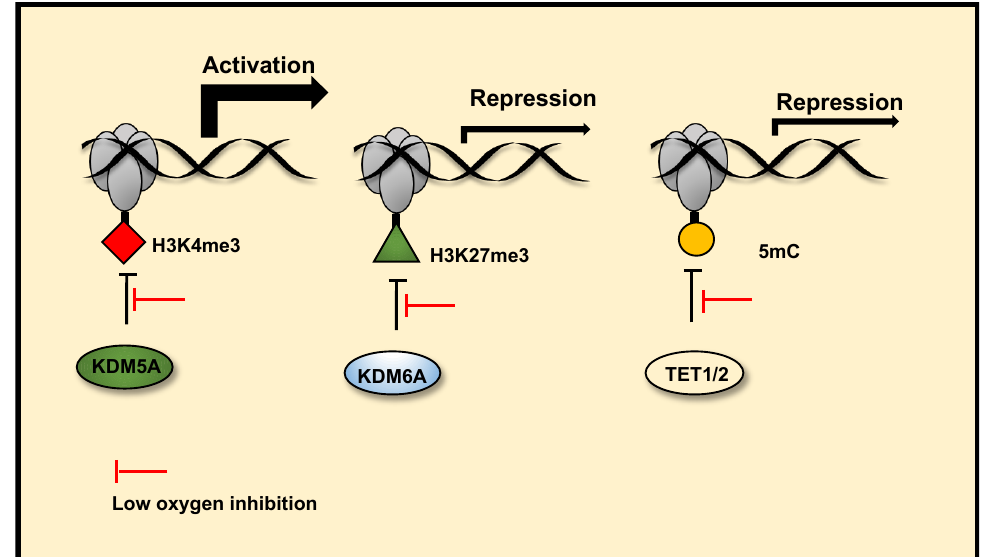
Figure 3. Chromatin oxygen sensing via JmjC histone demethylases and TETs. JmjC histone demethylases and TETs (mediators DNA demethylation) are 2-OGDs. Reduced activity of these enzymes in hypoxia, due to their oxygen sensitivity, can alter the chromatin landscape and mediate hypoxia induced transcription changes. Reduced activity of KDM5A in hypoxia increases H3K4me3 at the promoters of a subset hypoxia induced genes, facilitating their transcriptional activation. Reduced activity of KDM6A in hypoxia increases H3K27me3 at the promoters of a subset of hypoxia-repressed genes and represses their transcription. Reduced TET1/2 activity in hypoxia also represses gene transcription via DNA hypermethylation at gene promoters.